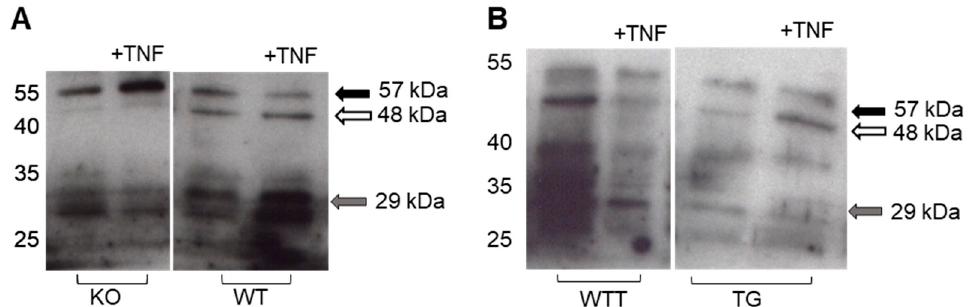
Figure 6. Effect of TNF- α on MMP-13 levels in conditioned media of KO and WT ( A ), and WTT and TG ( B ) skin explants incubated without or with 10 ng/mL TNF- α (+TNF) for four days and analyzed by western blot. The black arrow indicates the position of latent MMP-13 (57 kDa), the white arrow indicates the active MMP-13 (48 kDa) and the grey arrow the fragment containing the catalytic domain (29 kDa). Loading of samples was calculated relative to a pool of day four-conditioned media from all ( n = 17) control samples (50 µl of each sample were mixed). The reference pool was run together with the samples on 10% SDS-PAGE gels that were stained with Coomassie blue. The density of the common band at approximately 70 kDa was used for normalization (Supplementary Figure S1). The positions of protein markers in kDa are indicated to the left. KO ( n = 5), MMP-3 knock-out; WT ( n = 5), wild-type control to KO; WTT ( n = 3), wild-type to transgenic (TG); TG ( n = 4), MMP-3 overexpression in skin.